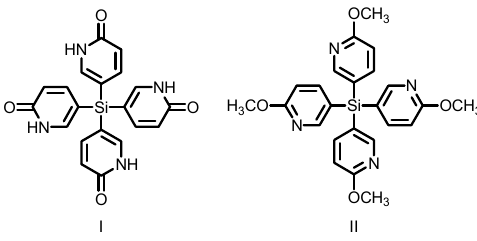
Figure 1. Structures of the building motifs I (left) and II (right).